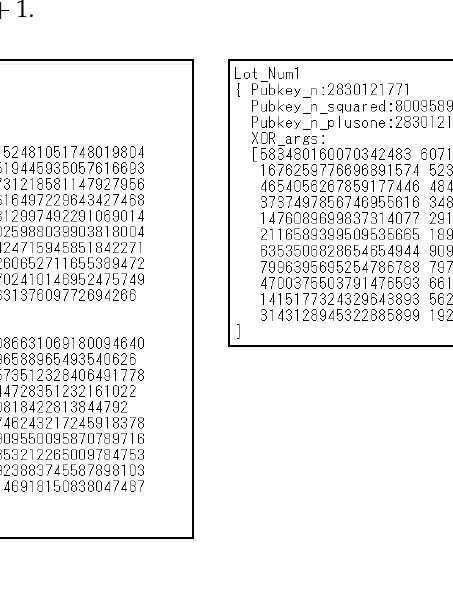
β CC; ( b ) Data structure of XOR